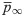
Variation of the long-term fraction p¯∞ of cooperators with average degree k and cost-to-benefit ratio ρ, in the donation game on model networks.(a)-(c) random regular networks; (d)-(f) exponential networks; and (g)-(i) scale-free networks. (a)(d)(g) p¯∞ versus k and ρ. The dashed lines show the graph of the relation 1ρ=k-1. (b)(e)(h) p¯∞ versus k when ρ = 0.1. The dashed lines show the critical degree kc=1ρ+1. (d)(f)(i) p¯∞ versus ρ when k = 4. The dashed lines show the critical value of the cost-to-benefit ratio ρc=1k-1.